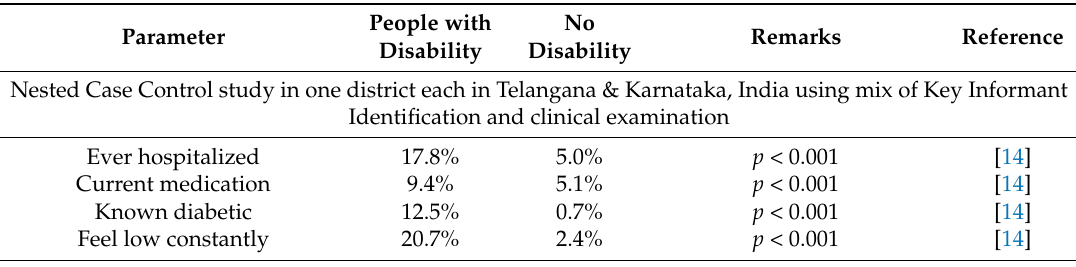
Table 2. Health Outcomes in Persons with